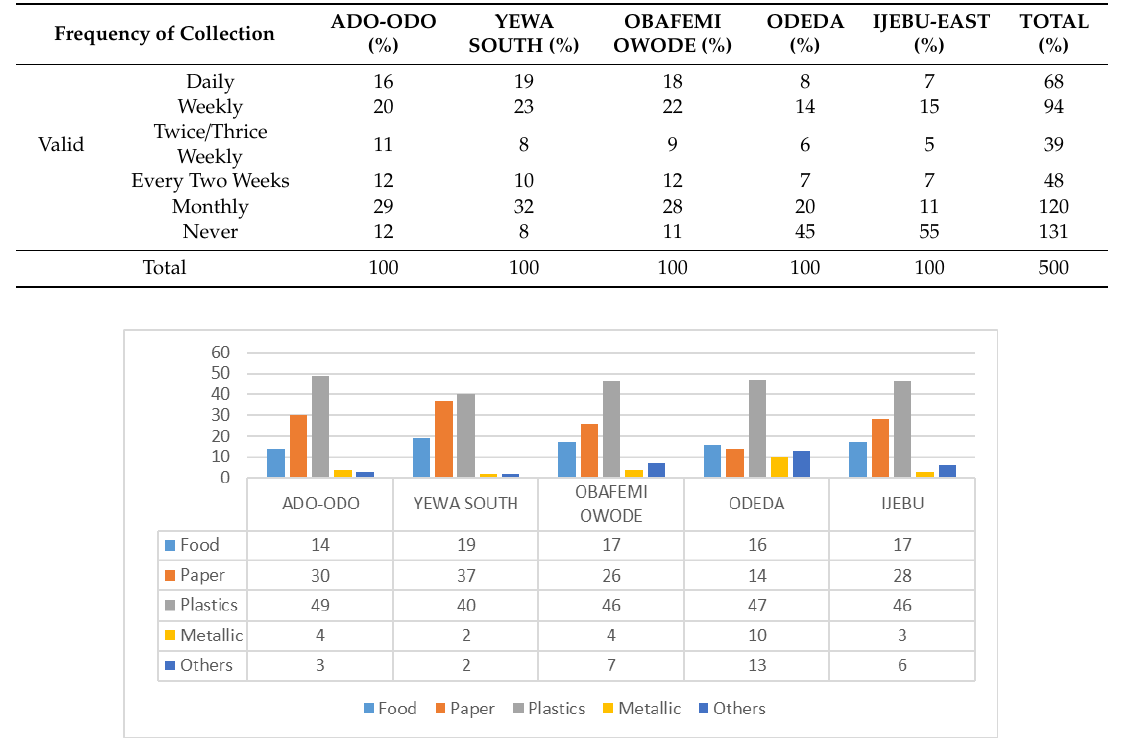
Figure 4. Responses on the most common types of solid waste generated. Table 8. Responses on the most common types of solid waste generated.